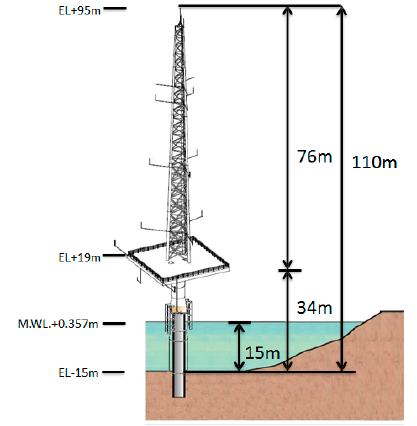
Figure 3. Taipower offshore meteorological mast.